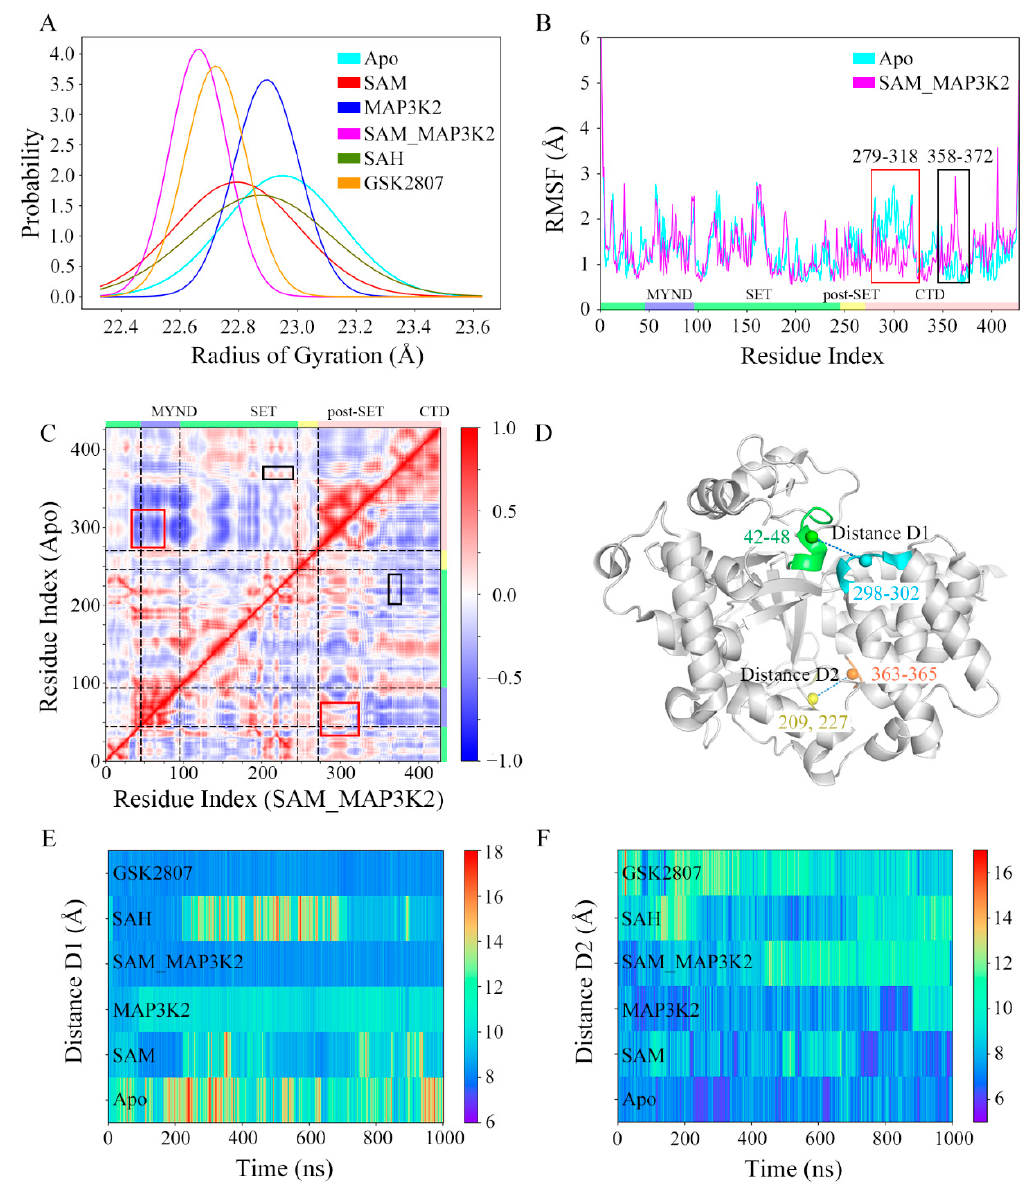
Figure 2. Conformational descriptors characterizing the dynamics of the CTD in SMYD3. ( A ) Distributions of RoG. The simulated systems are shown in cyan, red, blue, magenta, green and orange. The same scheme is used in the following figures unless otherwise specified. ( B ) RMSF analyses of the Apo and SAM_MAP3K2 systems. Two distinct differences are highlighted in the red and black boxes. ( C ) Dynamic cross-correlation maps for the Apo (upper left triangle) and SAM_MAP3K2 (lower right triangle) systems. The color scale is shown on the right changing from red (highly positive correlations) to blue (highly negative correlations). ( D ) Definition of distance D1 and D2 in the structure of SMYD3. Residues 42–48, 298–302, 209 and 227, and 363–365 are shown in green, cyan, yellow and orange, respectively. ( E ) Time evolutions of distance D1. The color scale is shown on the right changing from red (long distance) to blue (short distance). ( F ) Time evolutions of distance D2.